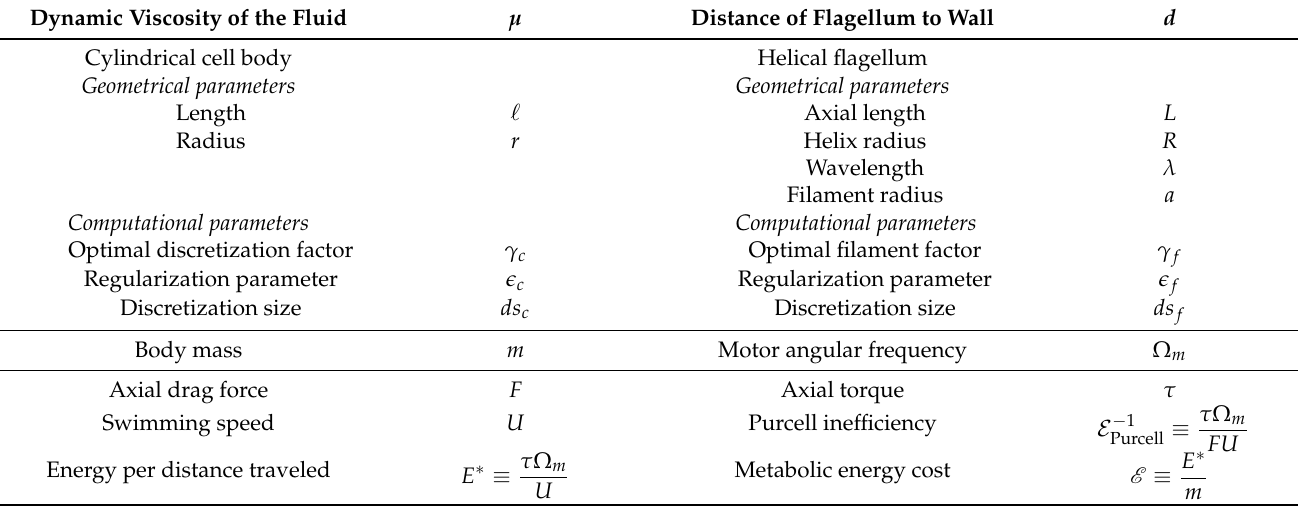
Table 1. Glossary of parameters for the computational and experimental